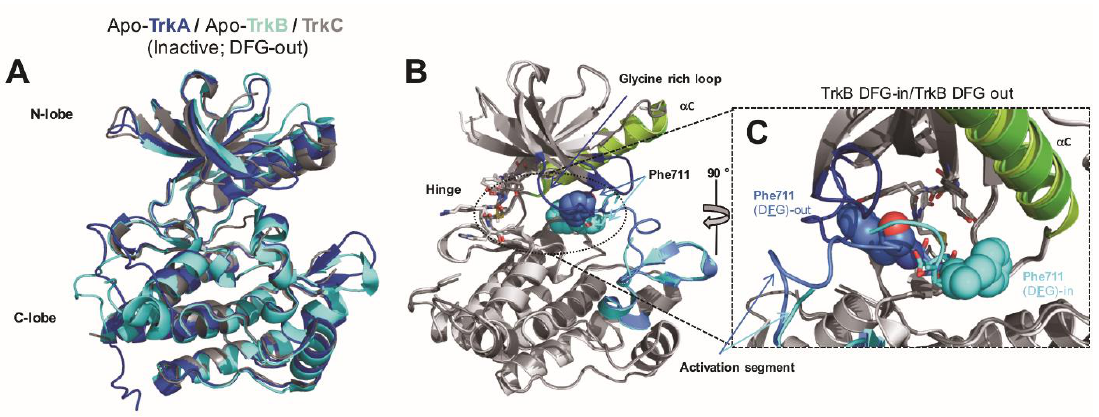
Figure 2. Trk kinase domain. ( A ) Overlap of TrkA, TrkB, and TrkC kinase domain (inactive